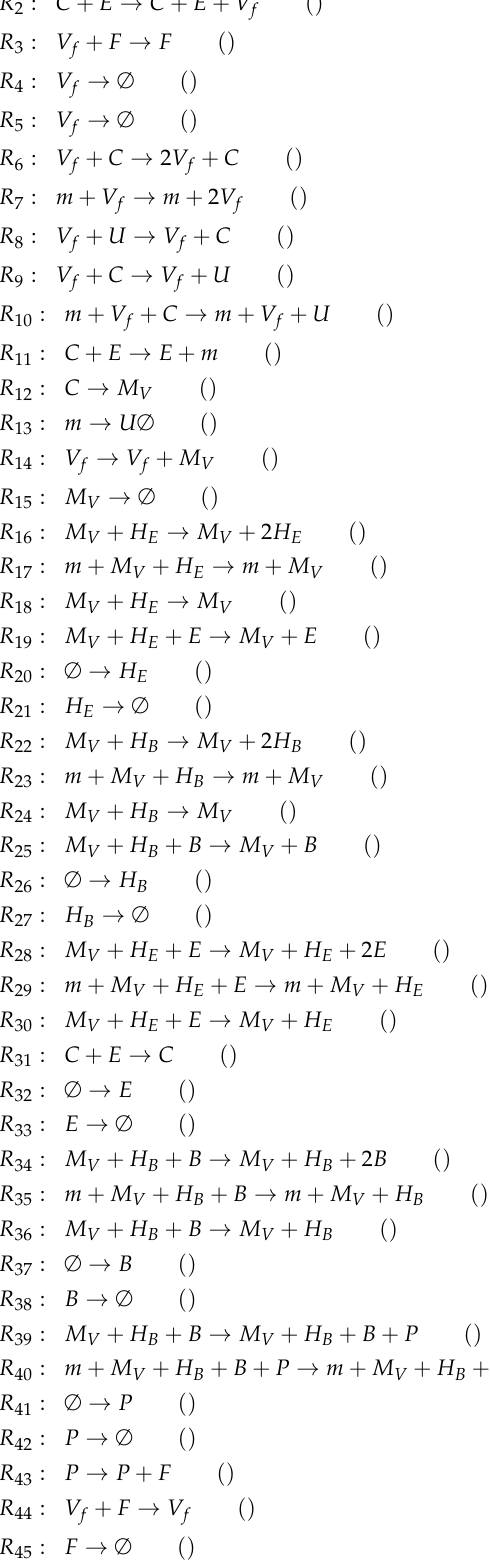
Figure A9. Reactions of Bocharov model